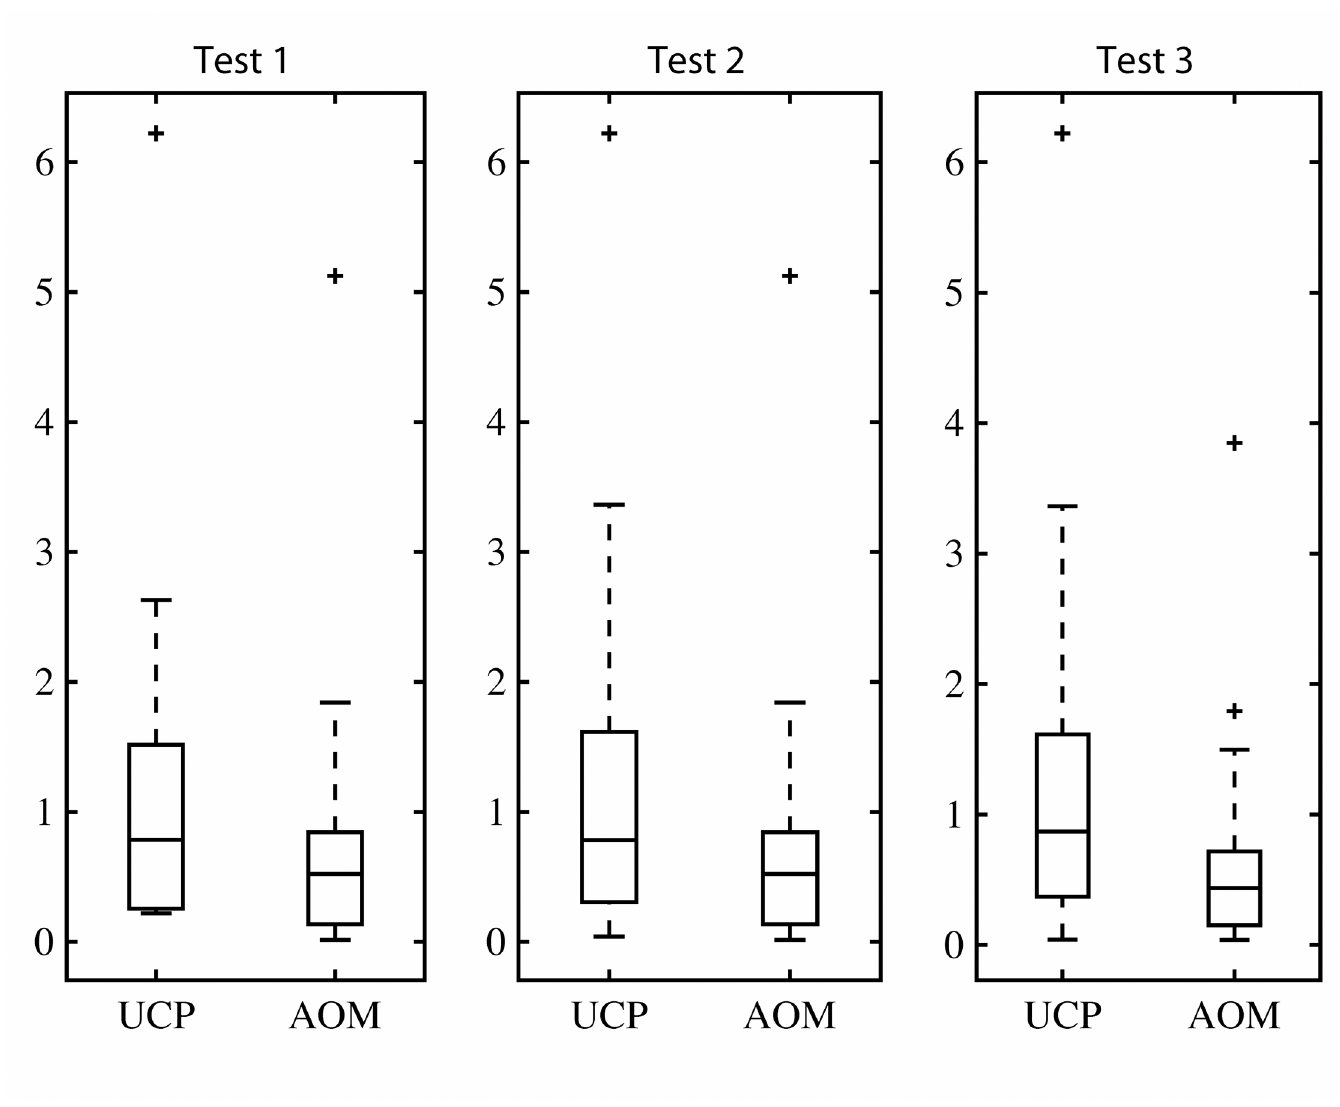
Fig 2. Box Plot on MRE Results obtained from testing